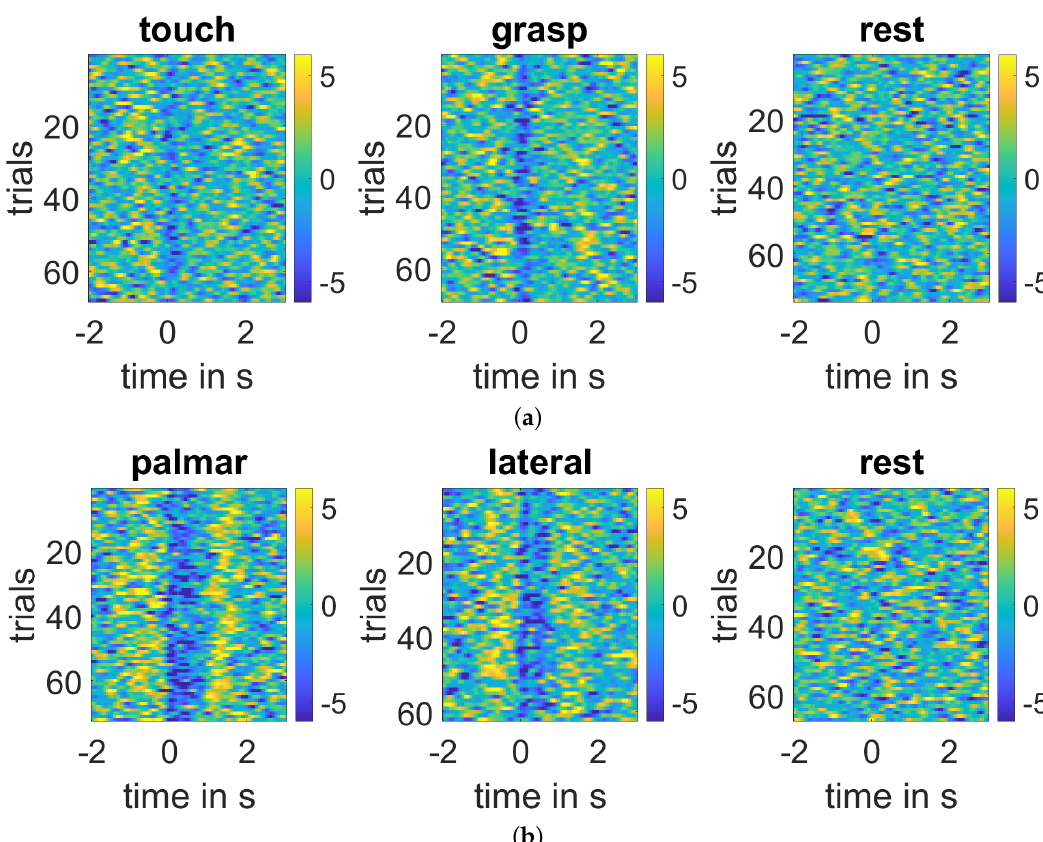
Figure 3. EEG segments (EEG amplitude in µ V) after synchronization to the movement onset. ( a ) Dataset 1 , representative participant Subject S000 , and channel C 1; ( b ) Dataset 2 , representative participant Subject G04 , and channel C